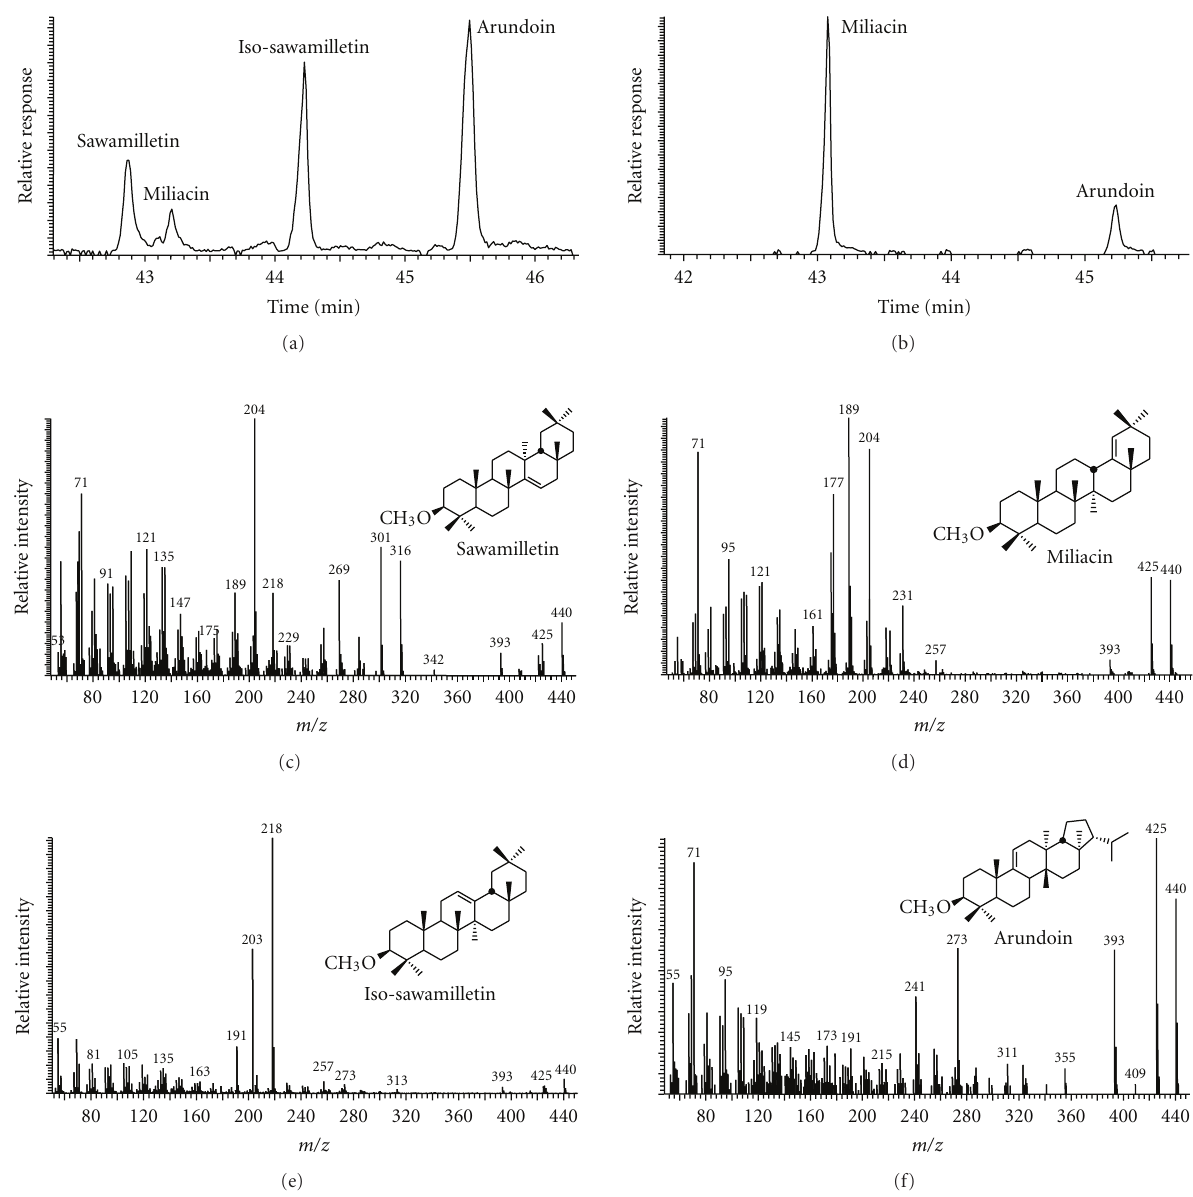
Figure 2: Examples of GC-MS data for triterpenoid methyl ethers in sediment extracts: (a) m/z 440 mass fragmentogram for sample GKR- 08, (b) m/z 440 mass fragmentogram for sample GKR-02, (c) mass spectrum of sawamilletin, (d) mass spectrum of miliacin, (e) mass spectrum of iso -sawamilletin, and (f) mass spectrum of